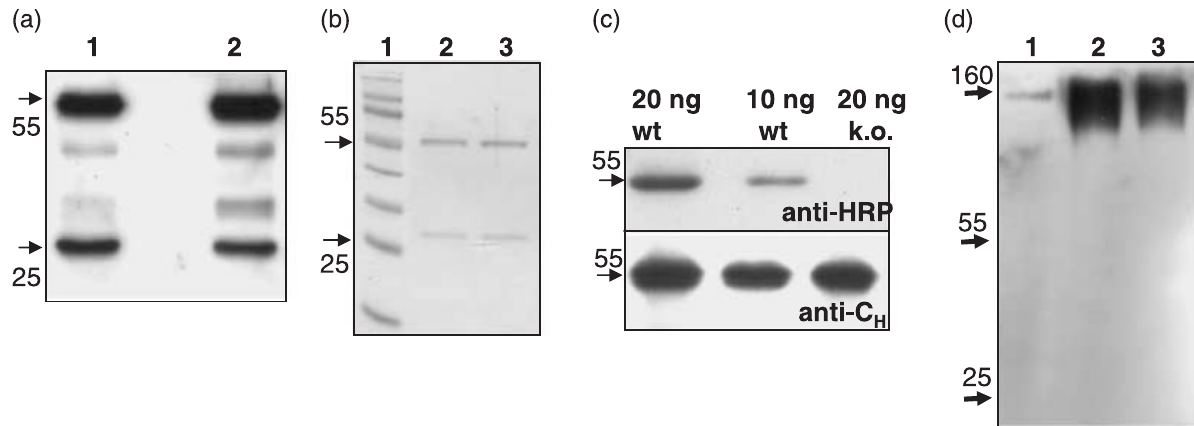
Figure 3 (a) Western blot analysis of proteins extracted from 2G12-transformed wild-type (wt) (lane 1) and β 1,2-xylosyltransferase and α 1,3-fucosyltransferase knockout (XT/FT k.o.) (lane 2) plants probed with rabbit anti-human immunoglobulin G (IgG) (C H and C L -specific). (b) Sodium dodecylsulphate-polyacrylamide gel electrophoresis (SDS-PAGE) (Coomassie Blue stained): lane 1, protein marker; 2G12 purified from wt Arabidopsis thaliana (lane 2) and k.o. line (lane 3). (c) Western blot analysis of purified 2G12 using anti-horseradish peroxidase (anti-HRP) antibodies (recognizing xylose and fucose) and goat anti-human IgG-( γ -chain-specific, anti-C H ): wt, 2G12 derived from A. thaliana wt; k.o., 2G12 derived from XT/FT k.o. line. (d) Western blot analysis of purified 2G12 after native PAGE using rabbit anti-human IgG (C H and C L -specific): lane 1, Chinese hamster ovary (CHO)-derived 2G12; 2G12 derived from wt A. thaliana (lane 2) and k.o. line (lane 3). Numbers next to the gels indicate the protein masses in